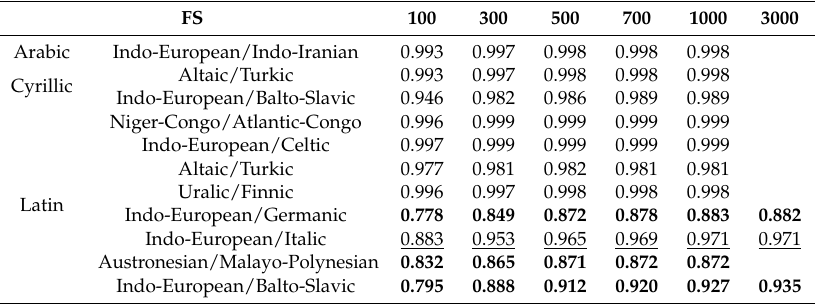
Table 19. LI in LG when using two-gram.